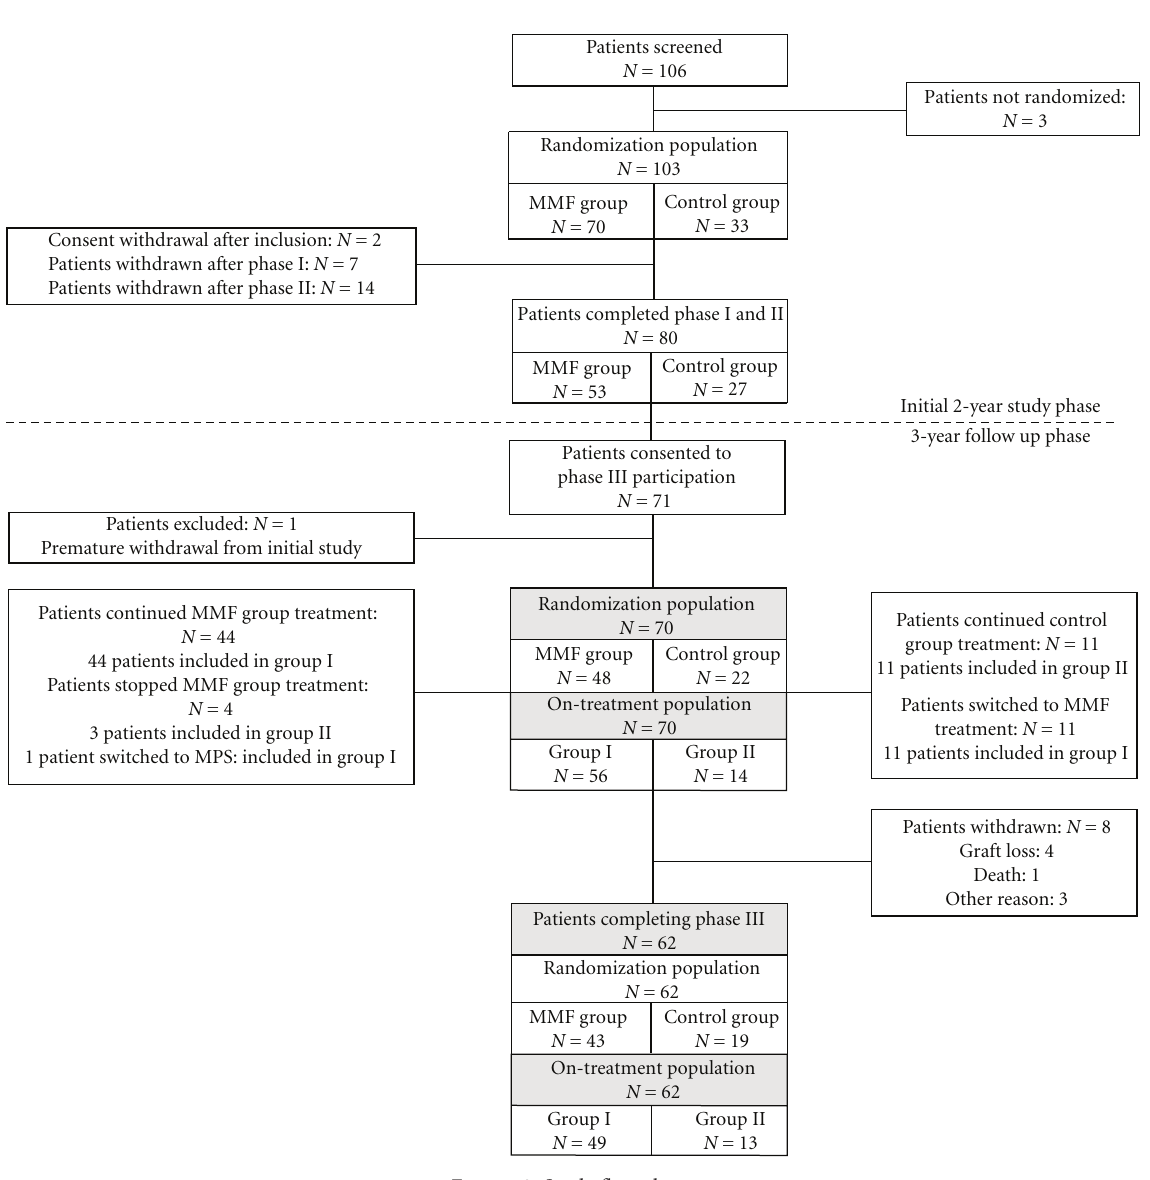
Figure 2: Study flow chart